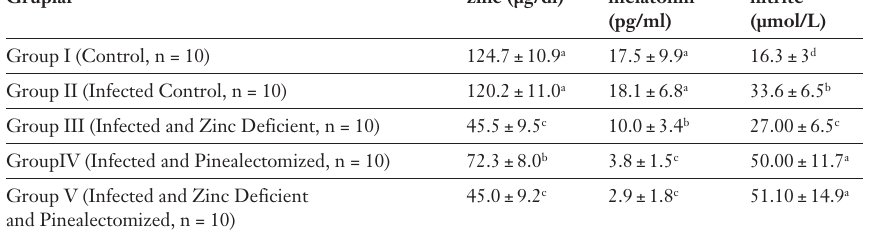
Plasma zinc, melatonin and nitrite levels of the control and study